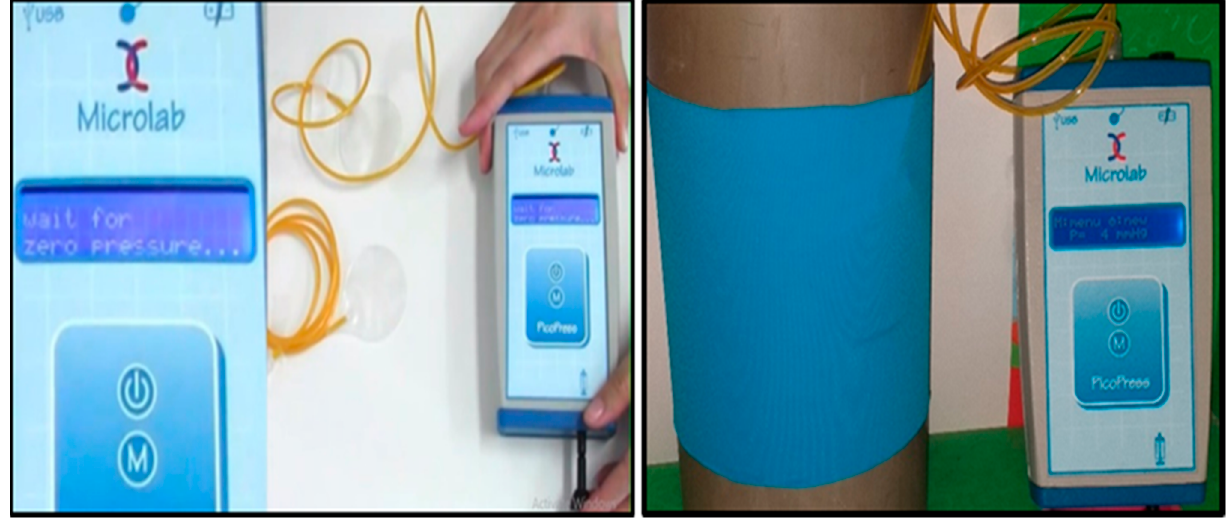
Figure 2. PicoPress ® pressure sensor device ( left ) used to measure fabric–rigid cylinder interface pressure in vitro ( right ) .